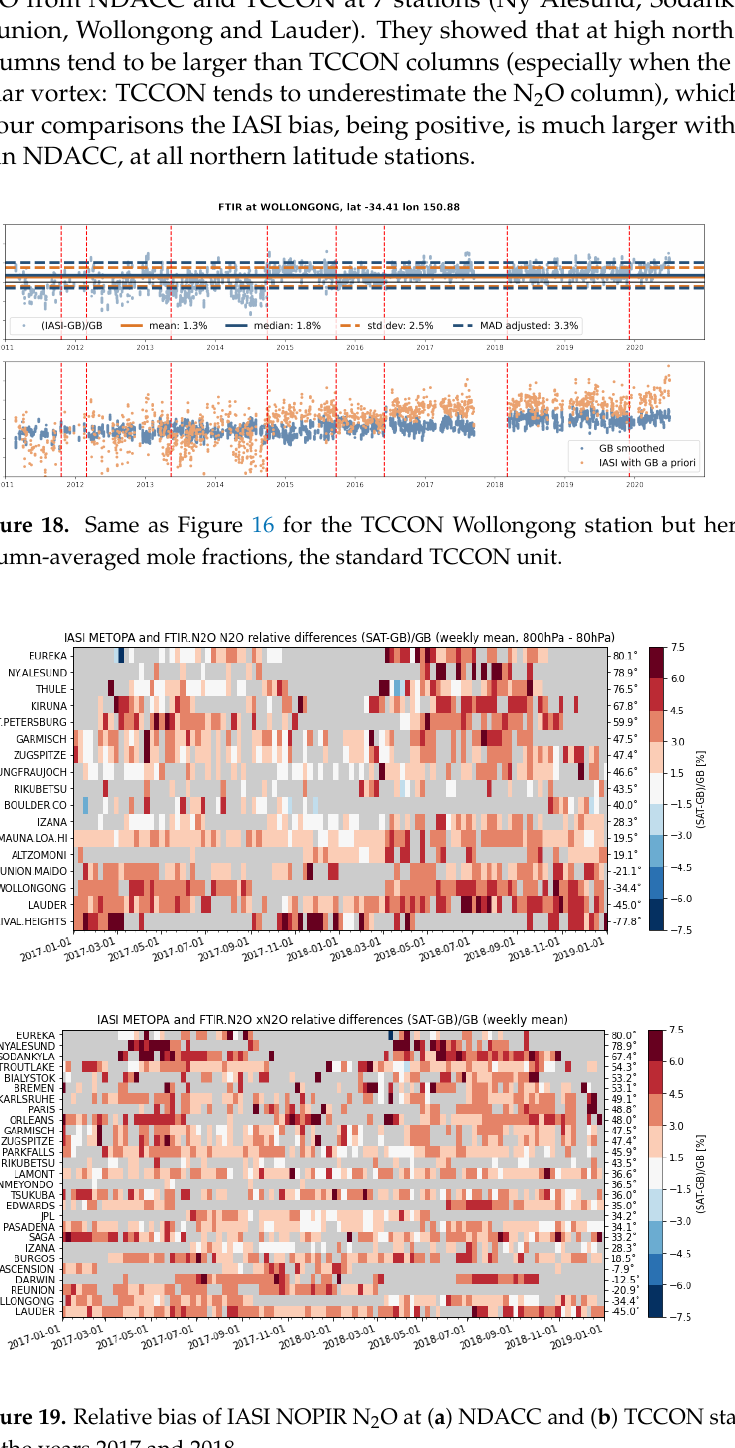
Figure 19. Relative bias of IASI NOPIR N 2 O at ( a ) NDACC and ( b ) TCCON stations: weekly average for the years 2017 and 2018